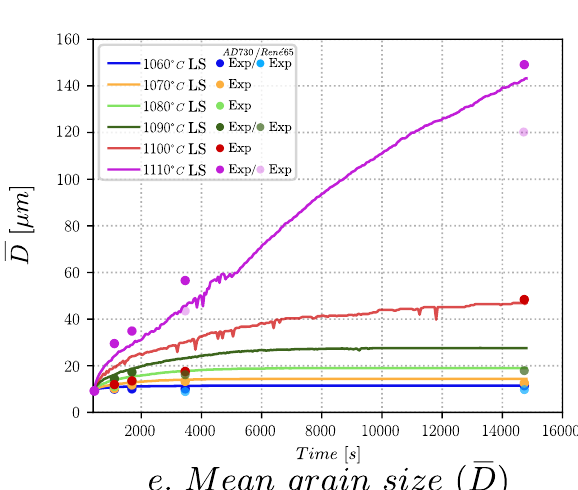
Figure 12. Simulation results for the AD 730 superalloy for different temperatures from T solvus to 50 ◦ below